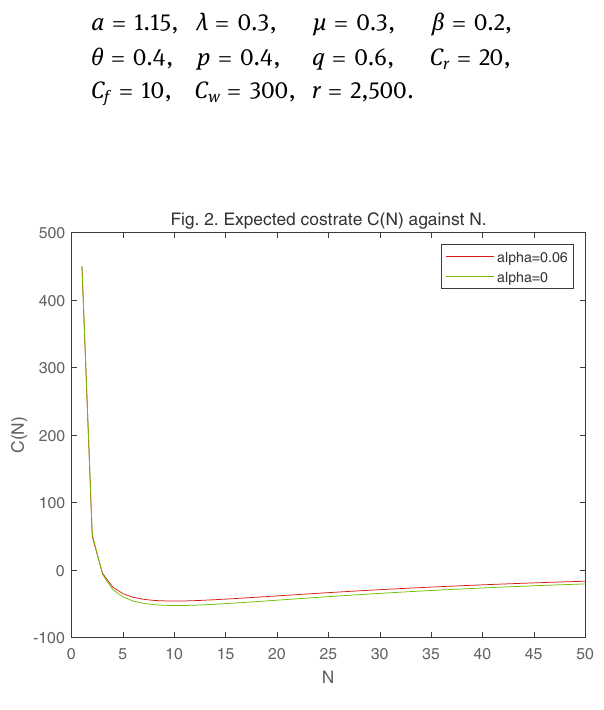
Fig. 2. Expected costrate C(N) against N.